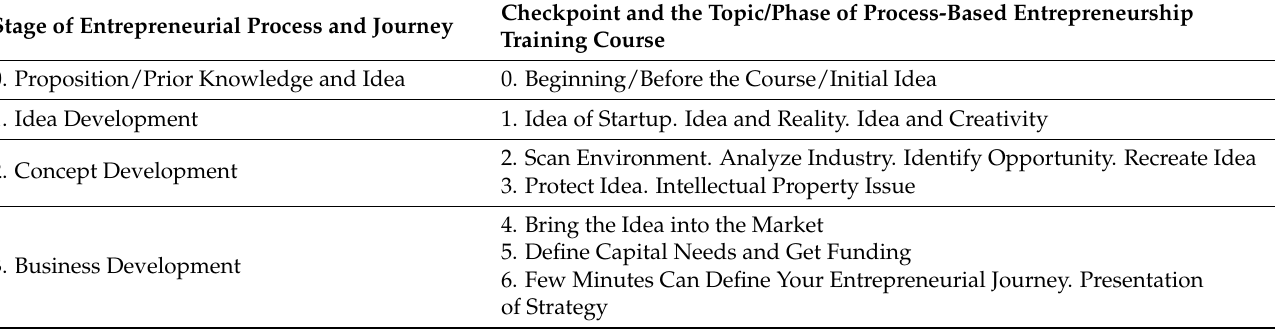
Table 1. Structure of Entrepreneurial and Learning